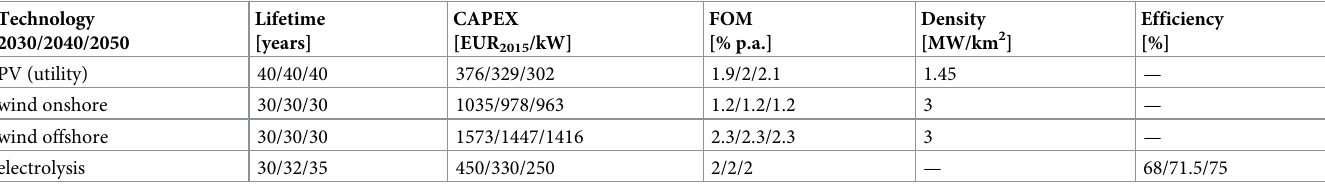
Table 3. Main technology assumptions for RES and